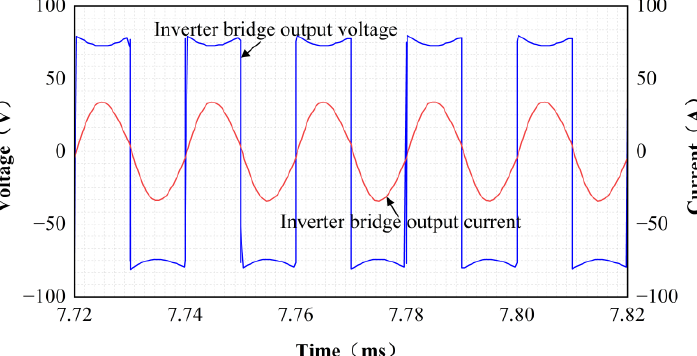
Figure 13. Diagram of the magnetic coupling unit and the overall AUV system. Table 3. Parameters of the new cores measured by the LCR measuring instrument. Parameters